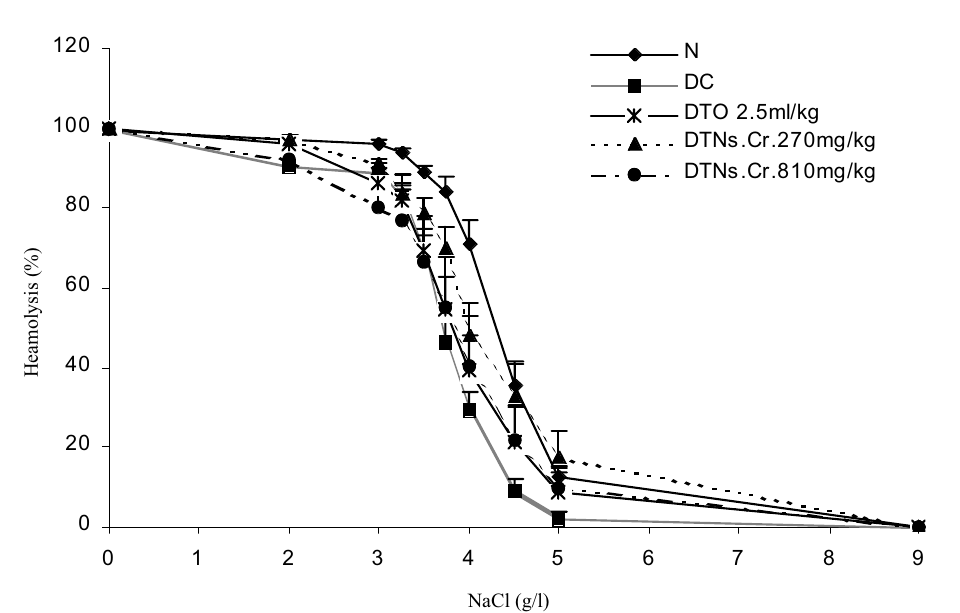
Figure 4. The degree of heamolysis of erythrocytes at different osmotic concentrations of sodium chloride solu- tions in all groups. N, normal rats group (n=5); DC, diabetic control rats group (n=5); DTNs.Cr, N. sativa crude extract treated diabetic rats group (n=5); DTO, oil treated diabetic group (n=5). Values are expressed as mean ±